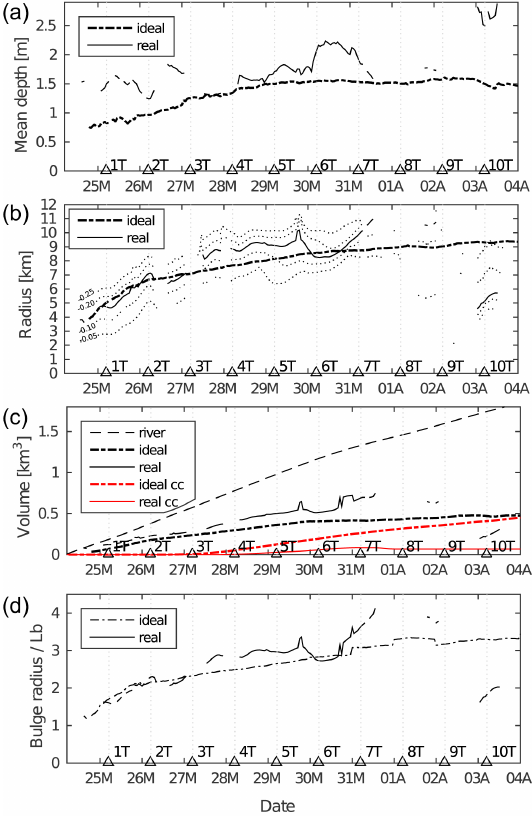
Figure 7. Time series of the Daugava River bulge mean depth (a) , bulge radius (b) , bulge volume (c) and the bulge effective radius scaled with the bulge Rossby radius (d) . The solid line represents the real model simulation and the dash-dotted line the idealized model simulation. Time series of the bulge radius where the bulge is defined: I = log 10 (TSM)> − 0 . 05 ;− 0 . 10 ;− 0 . 20 ;− 0 . 25 (dotted) (b) . Time series of cumulative river water (dashed), bulge volume (black) and volume of the coastal current (red) in the real model simulation (solid) and ideal model simulation (dash-dotted) (c) . Triangles represent the rotation period of the earth starting from 24 March 2007